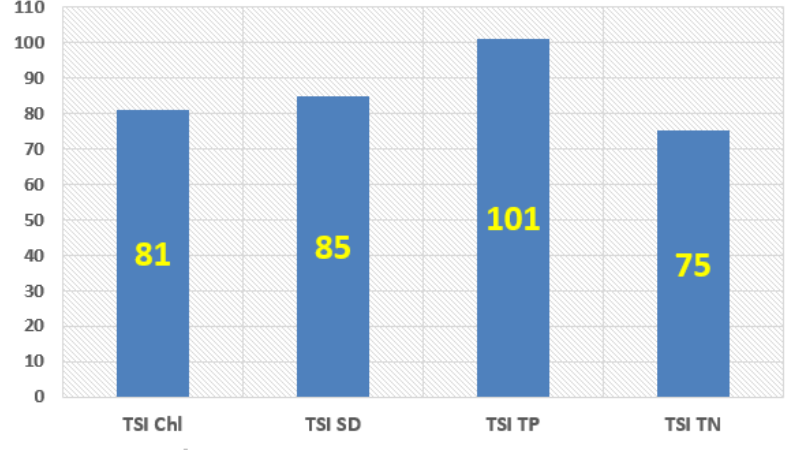
Figure 3. The trophic status index (TSI) calculated on the basis of visibility (SD) chlorophyll concentrations (Chl), total phosphorus (TP) and total nitrogen (TN).